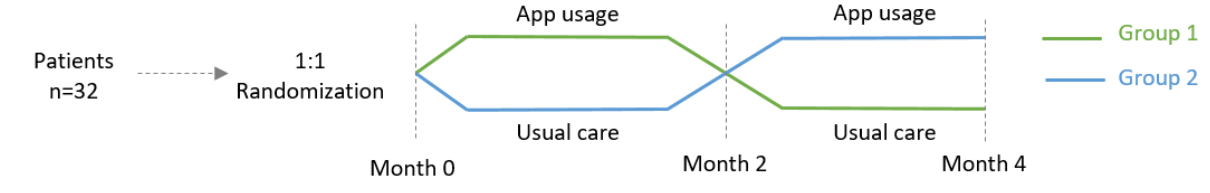
Figure 1. The process of randomization showing change in phases of the study for both groups before and after